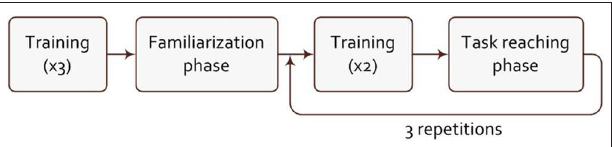
FIGURE 7 | Diagram of the experimental